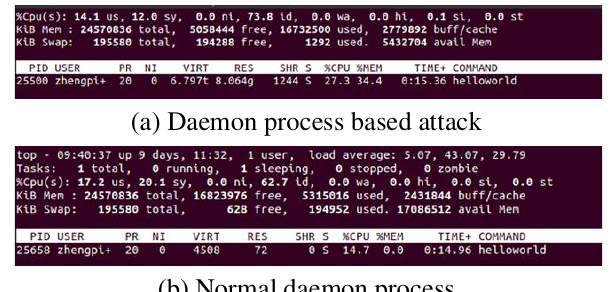
Figure 1. Comparison of CPU and memory usage (a) when running a daemon-process attack and (b) when running normal daemon